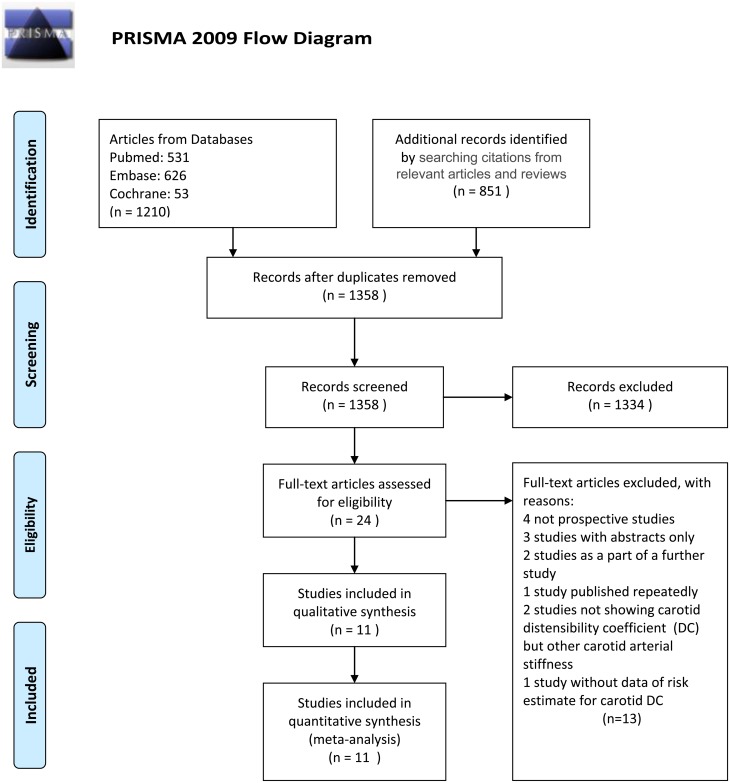
Flow chart for study selection in the meta-analysis.From: Moher D, Liberati A, Tetzlaff J, Altman DG, The PRISMA Group (2009). Preferred Reporting Items for Systematic Reviews and Meta-Analyses: The PRISMA Statement. PLoS Med 6(6): e1000097. doi:10.1371/journal.pmed1000097.For more information, visit www.prisma-statement.org.